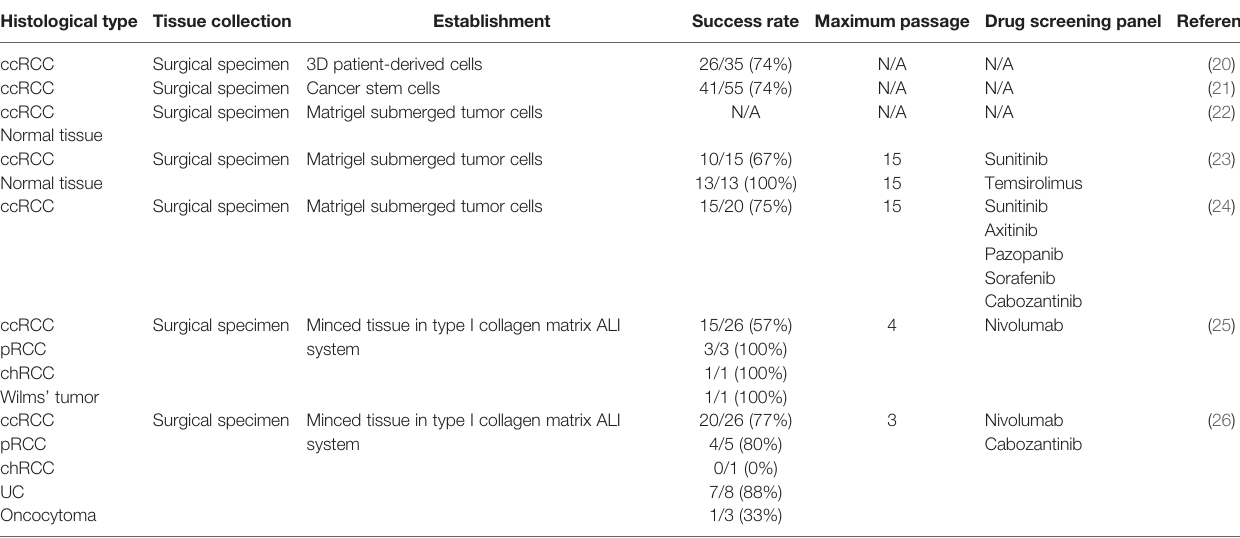
TABLE 1 | Published articles on establishment of patient-derived organoids of renal cell carcinoma. Histological type Tissue